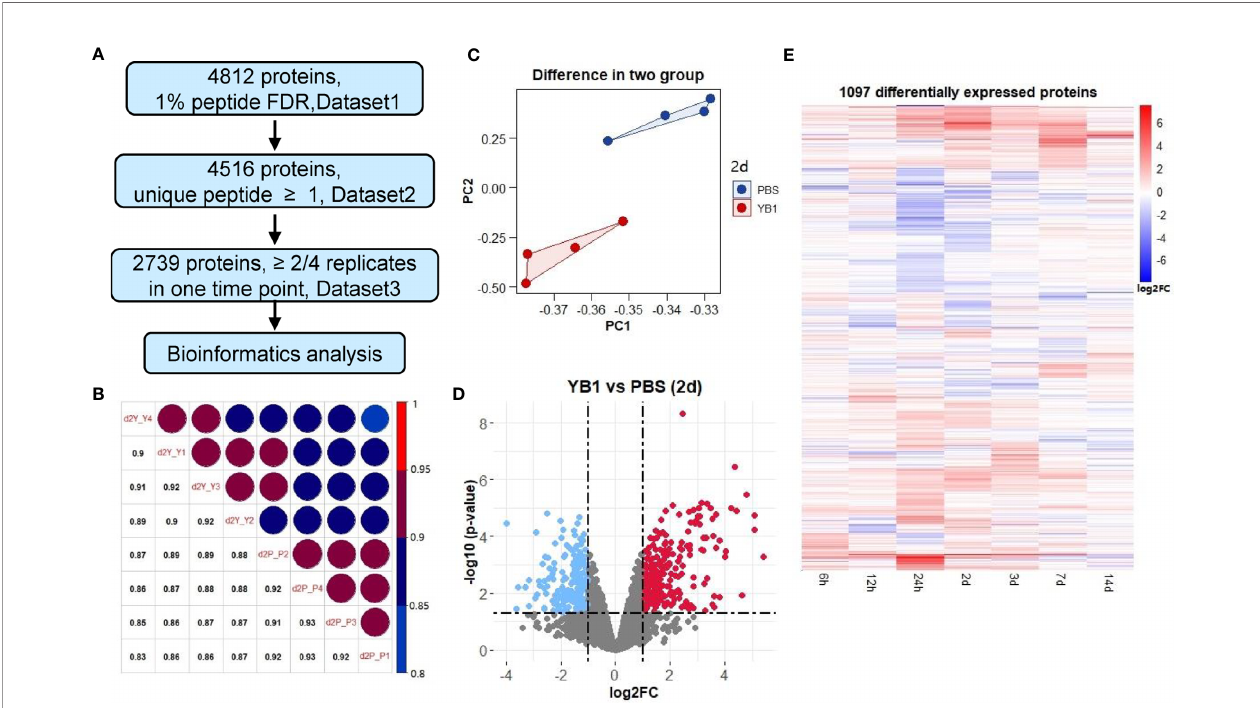
FIGURE 2 | Quantitative proteomics revealed differential protein expressions in tumor induced by YB1 treatment. (A) Multiple data sets with different fi ltering criteria. (B) Replicate correlation of YB1 versus PBS samples for the indicated time points (2 day). (C) Principal component analysis of the proteomics data at 2 day. Each dot represents an independent biological replicate. (D) Analysis of signi fi cantly dysregulated proteins in YB1 (determined by t -test). Volcano plots of YB1 versus control comparisons. p- values (-log base 10) are plotted as a function of the proteins ratio (log base 2) for YB1 versus PBS group. (E) Hierarchical clustering of differentially expressed proteins by semi-supervised, Ward ’ s hierarchical